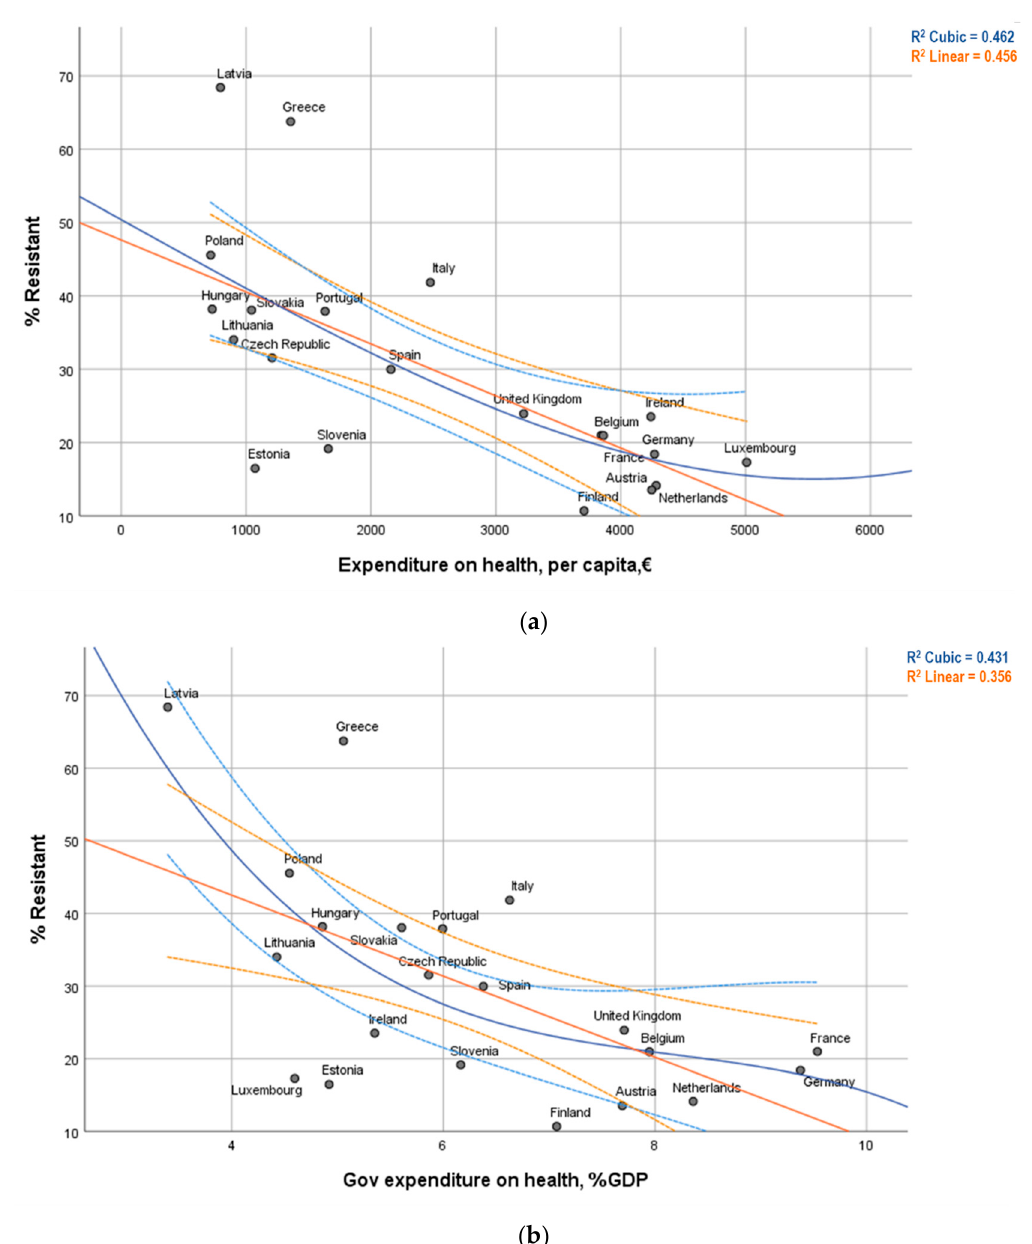
Figure 1. Scatterplot, linear and cubic regression models (and 95% Confidence Intervals) for the relation between Percentual AMR rate with ( a ) Expenditure on health per capita; and ( b ) Government expenditure on health as a percentage of the country GDP.